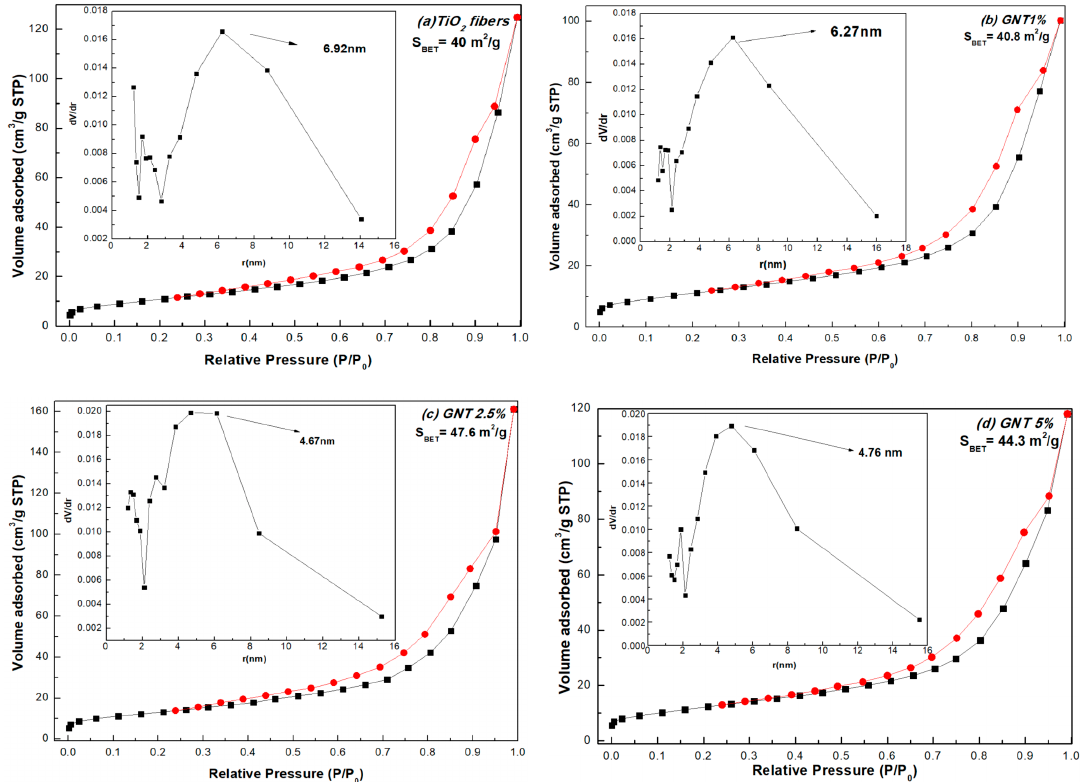
Figure 3. Nitrogen adsorption-desorption isotherms and pore size distributions for the prepared